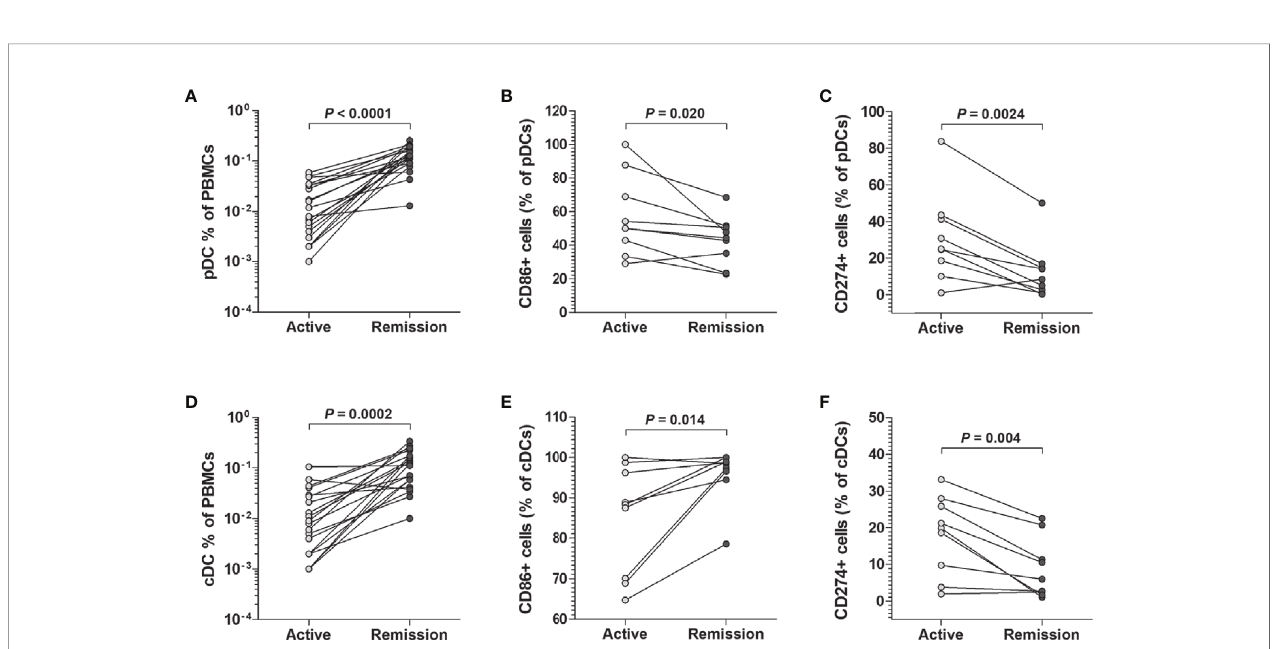
FIGURE 4 | Changes in cell percentages and surface phenotypes of circulating pDCs and cDCs from scrub typhus patients. The percentages of pDCs (A) and cDCs (D) in the peripheral blood of 20 scrub typhus patients during active and remission states were determined by fl ow cytometry. The percentages of CD86- expressing (B, E) , and CD274-expressing (C, F) pDCs and cDCs were determined by fl ow cytometry. The data in (B C, E, F) were obtained from nine patients with scrub typhus. The symbols represent individual subjects. P values were calculated by Wilcoxon matched-pairs signed-rank